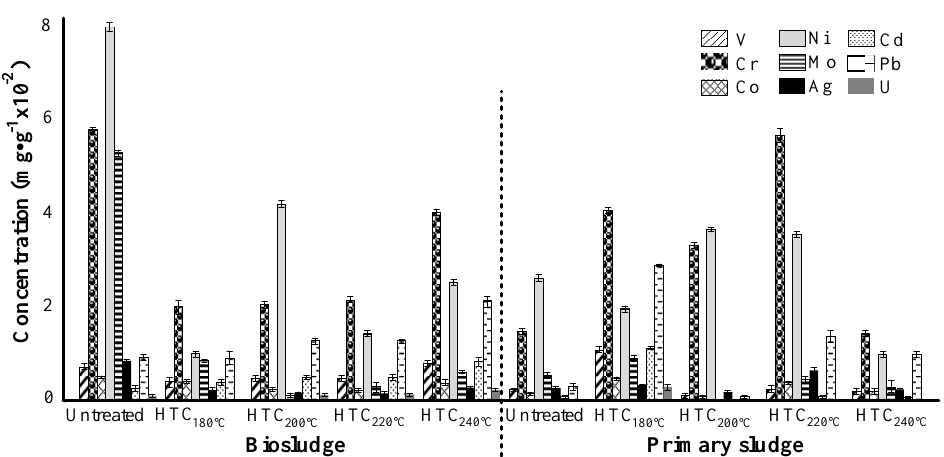
Figure 3. Inorganic elements in feedstock and hydrochar BS and SP samples.